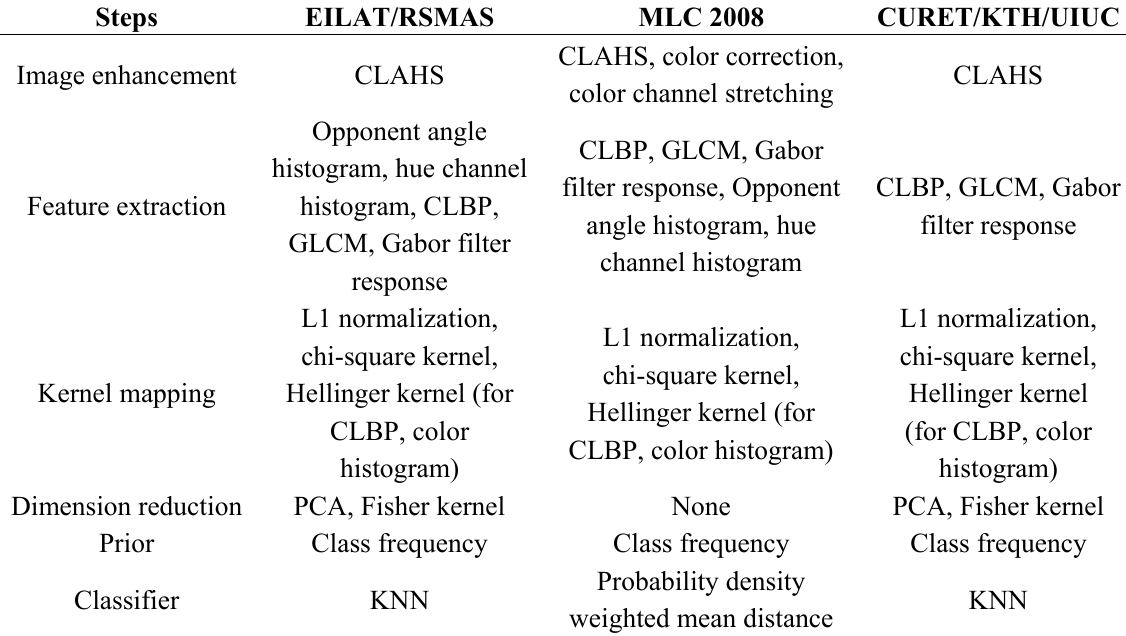
Table 8. Selected configuration for our method. Three different configurations are used for (1) EILAT and RSMAS datasets, (2) MLC 2008 dataset and (3) Columbia-Utrecht Reflectance and Texture (CURET), Kungliga Tekniska Högskolan (KTH), University of Illinois at Urbana-Champaign (UIUC) datasets. Contrast limited adaptive histogram specific (CLAHS), completed local binary pattern (CLBP), grey level co-occurrence matrix (GLCM), principal component analysis (PCA) and k-nearest neighbor (KNN) are used in the table as acronyms. Steps Image enhancement